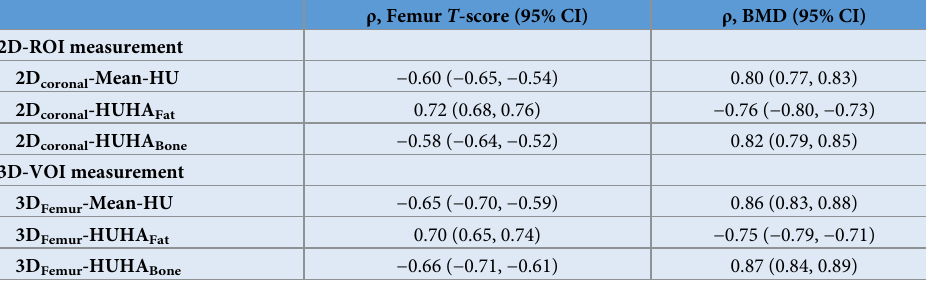
Table 2. Correlation analysis results with femur T -score and